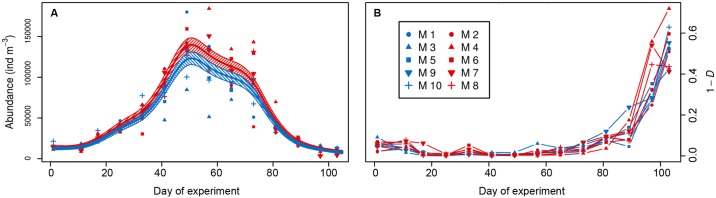
Mesozooplankton community.A) Mesozooplankton abundances. Solid lines = prediction from Generalized Additive Mixed Models (GAMMs) (smoother trends p-value < 0.05) with ambient and high-pCO2 mesocosms separately; striped area = confidence interval. B) Simpson’s Diversity Index (1-D) in relation to pCO2 levels within the mesocosms along the study period. Symbols and colours (blue = ambient; red = high-pCO2 treatment) identify each mesocosm.